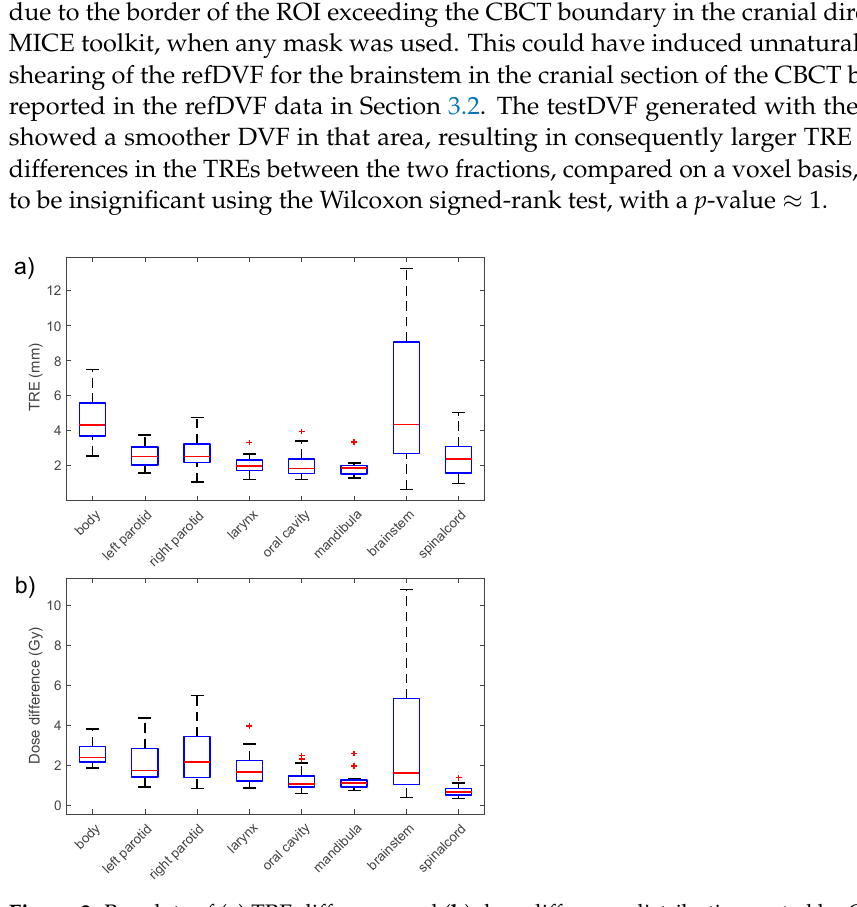
Figure 3. Boxplots of ( a ) TRE difference and ( b ) dose difference distribution sorted by OAR. For each box, the central mark represents the median value, while the bottom and top edges of the box are the 25th and 75th percentiles, respectively. The ‘whiskers’ represent the range of values. Observations beyond the whisker length are marked as outliers (+). By definition, an outlier is a value that is more than 1.5 times the interquartile range away from the bottom or top of the box. An outlier appears as a red +